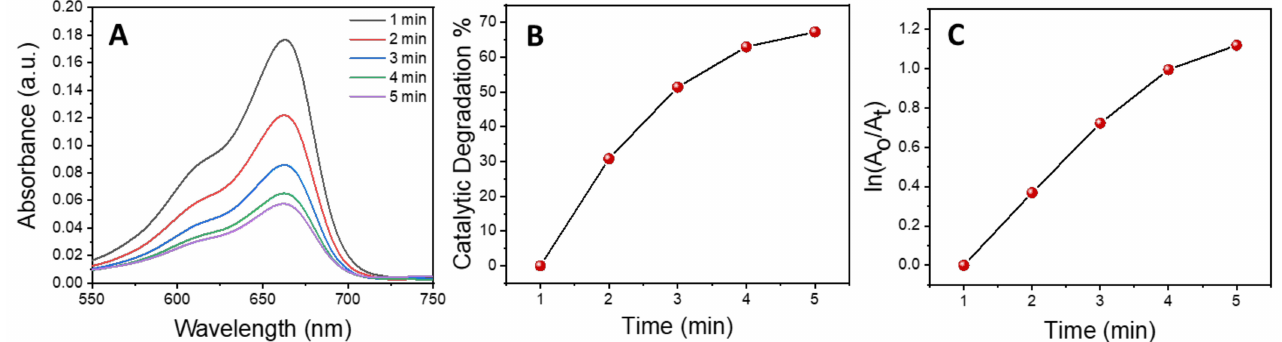
Figure 10. ( A ) Absorption spectra of MB solution at various reaction times in the existence of Ag-based NPs, ( B ) the catalytic reduction (expressed in %) versus time, and ( C ) the first-order kinetic